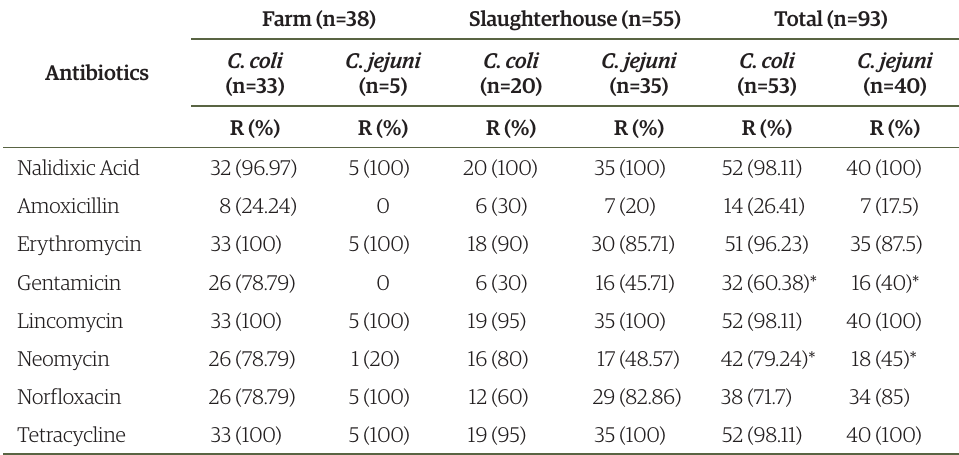
Table 2. Distribution and antibiotic resistance profile of strains of C. coli and C. jejuni , isolated from feces of pigs settled on the farm and at the slaughterhouse pen.